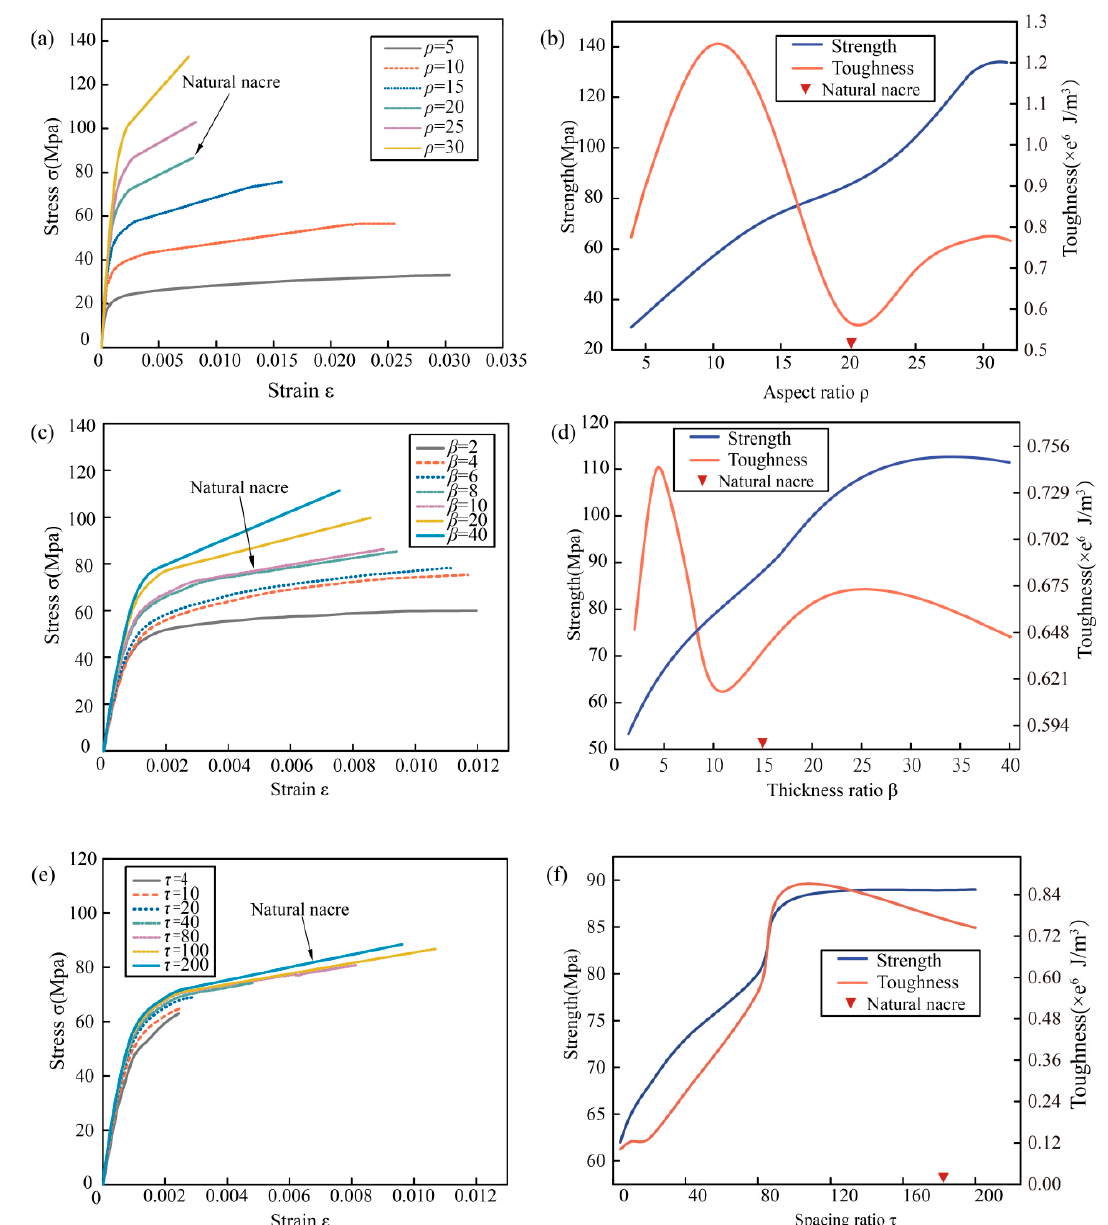
Figure 4. Stress ‐ strain and strength ‐ toughness curves with different structural parameters: ( a ) tensile behavior with different ρ , ( b ) effect of ρ on strength and toughness, ( c ) tensile behavior with different β , ( d ) effect of β on strength and toughness, ( e ) tensile behavior with different τ, ( f ) effect of τ on strength and toughness.